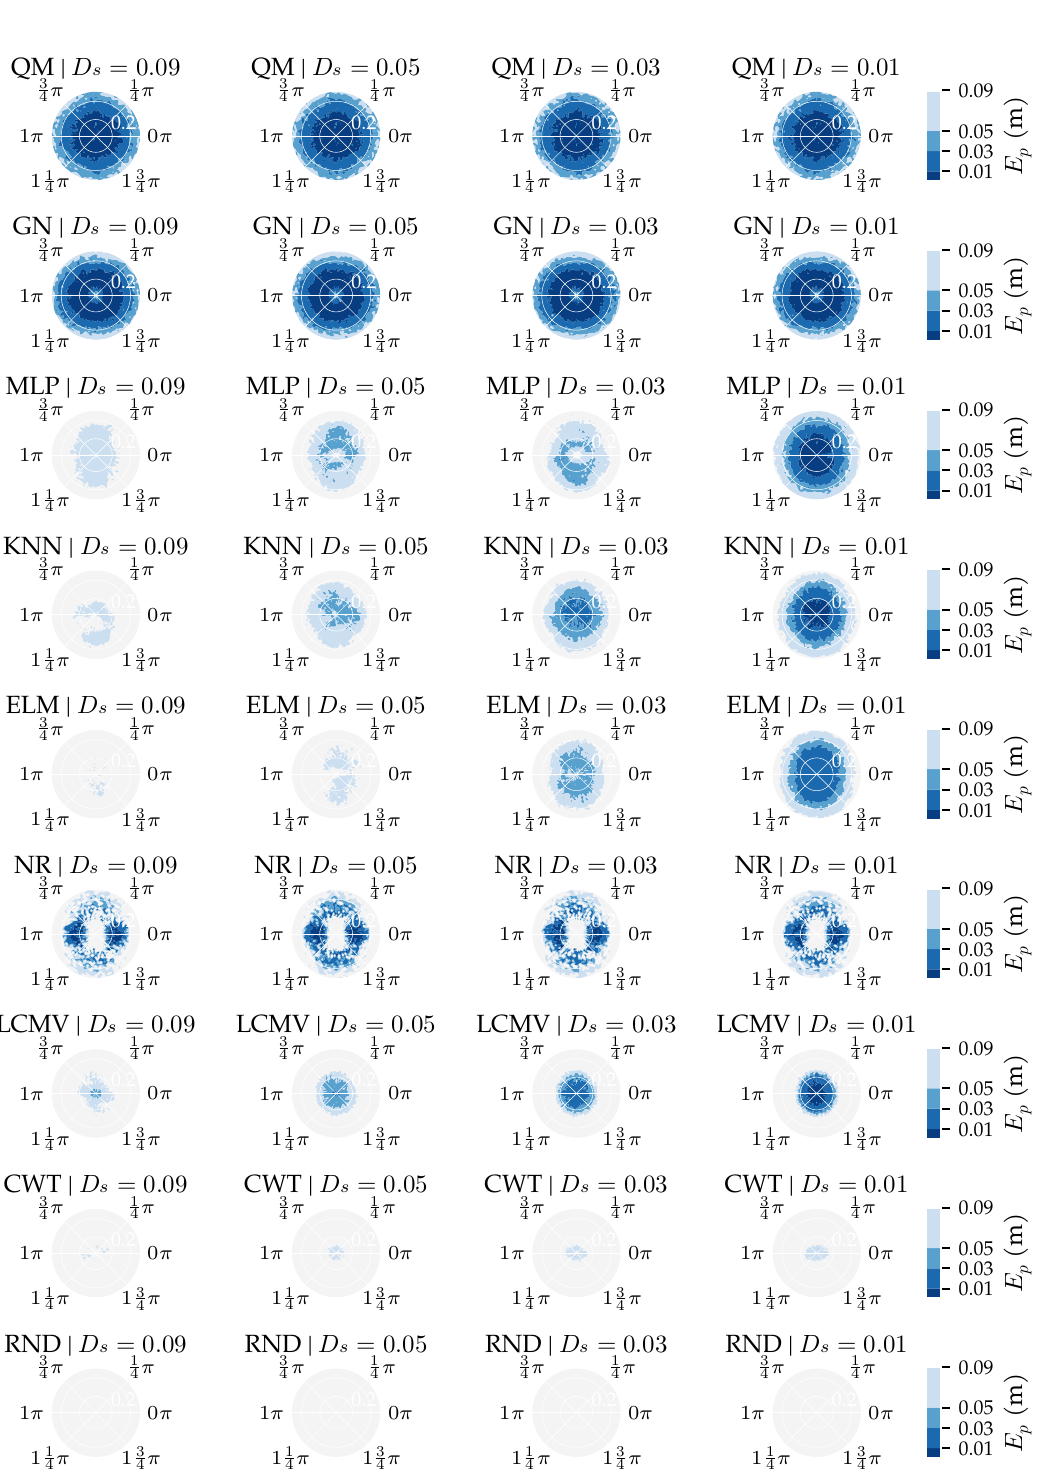
Figure A6. Polar contours of the median position error (Equation (4)) for each localisation algorithm in all conditions of Analysis Method 1. These figures indicate how the movement direction ϕ and distance d of a source influence the error. This analysis varied the minimum distance D s between sources in the training and optimisation sets (Table 1) while using the (x + y) sensor configuration at the σ = 1 × 10 − 5 ms − 1 noise level. The median position error was computed in 2 × 2 cm 2 cells. The sensors were equidistantly placed between x = ± 0.2